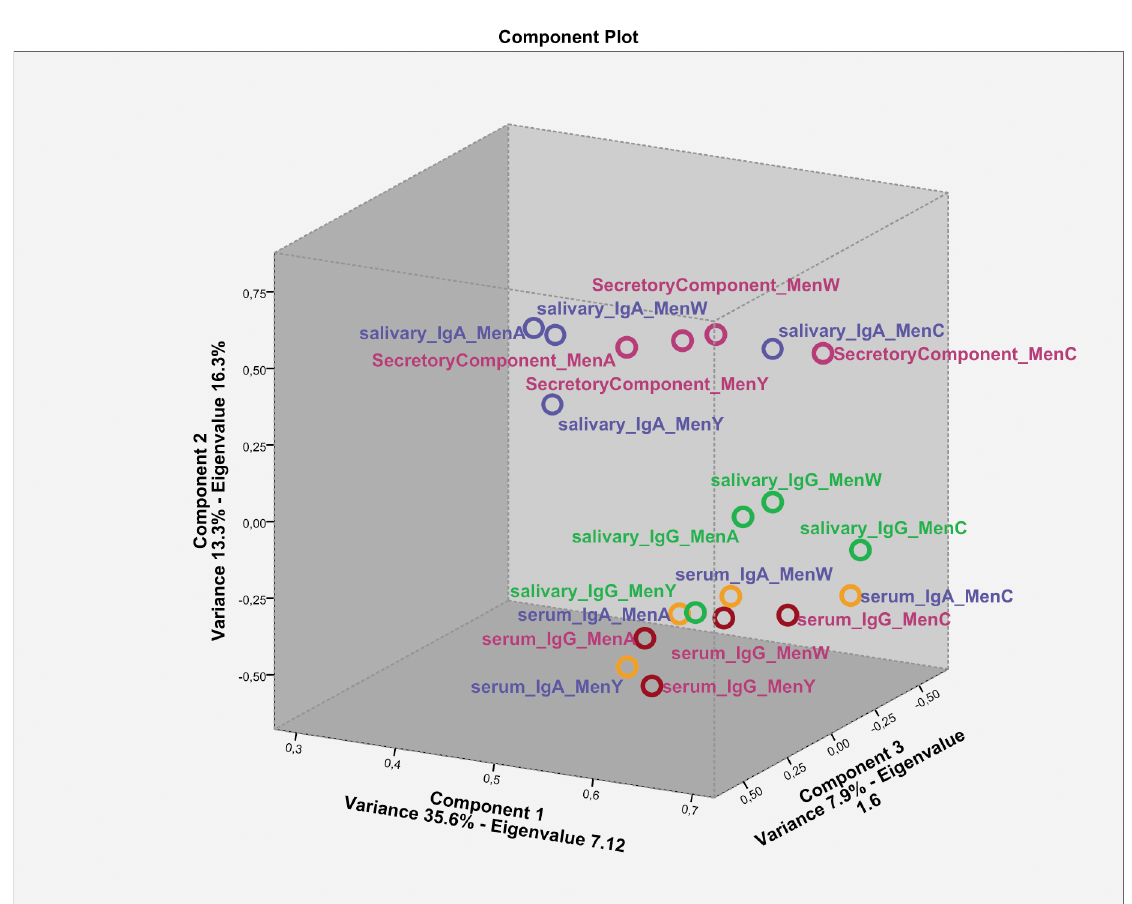
Fig 4. Principal components analysis of serum and saliva IgG and IgA levels to the different meningococcal serotypes. For this analysis, data of T1 was selected as these data had the highest variance. The Eigenvalues (have to exceed 1 to be explanatory) and the variance explained along the component axes are indicated. SBA = serum bactericidal